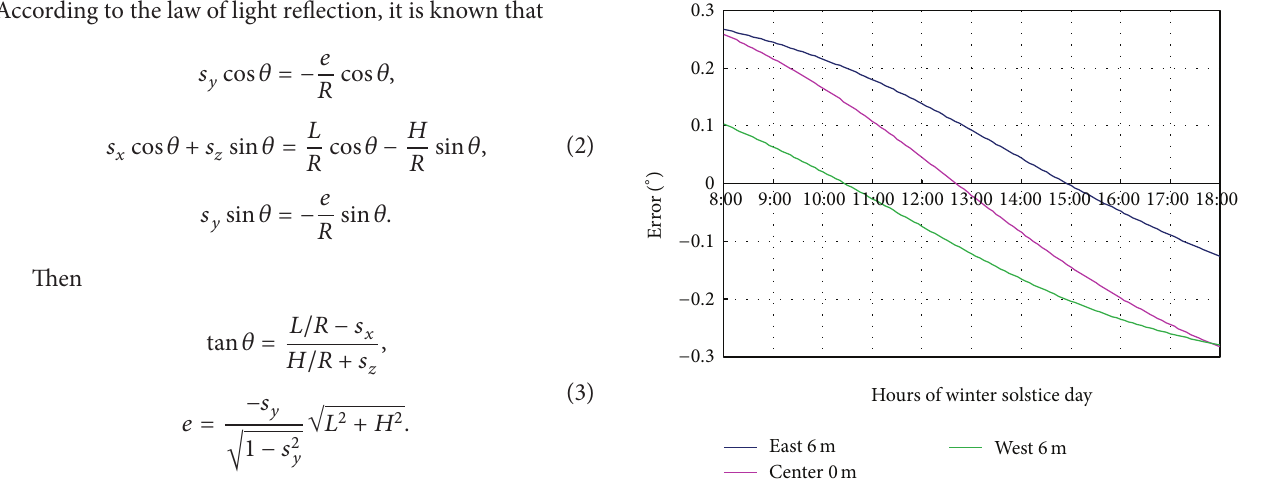
Figure 3: The tracking error caused by eccentric deviation of different column.